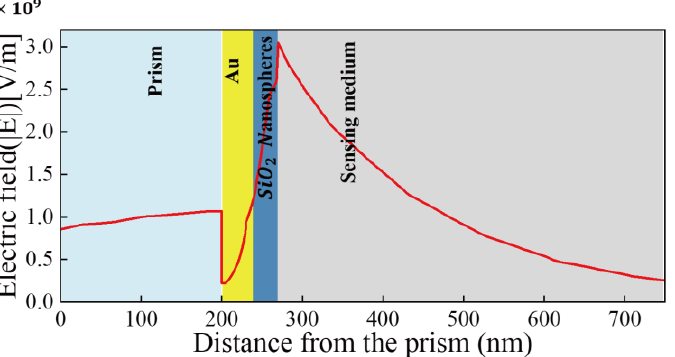
Figure 10. Electric field distribution (the red line) at different interfaces at the resonance wavelength for the medium refractive index 1.330.